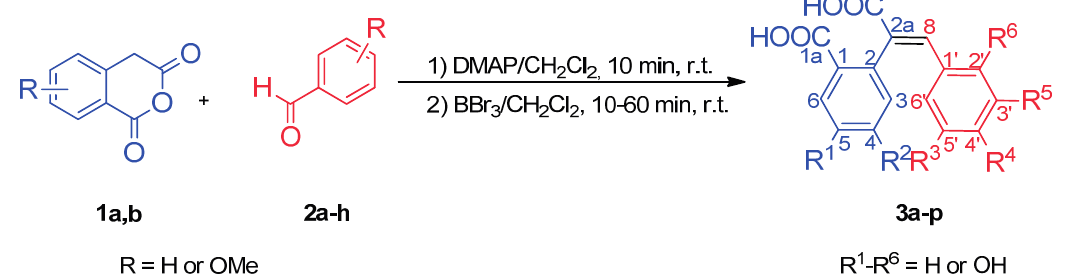
Scheme 1. One-pot synthesis of polyhydroxylated trans -restricted 2-arylcinnamic